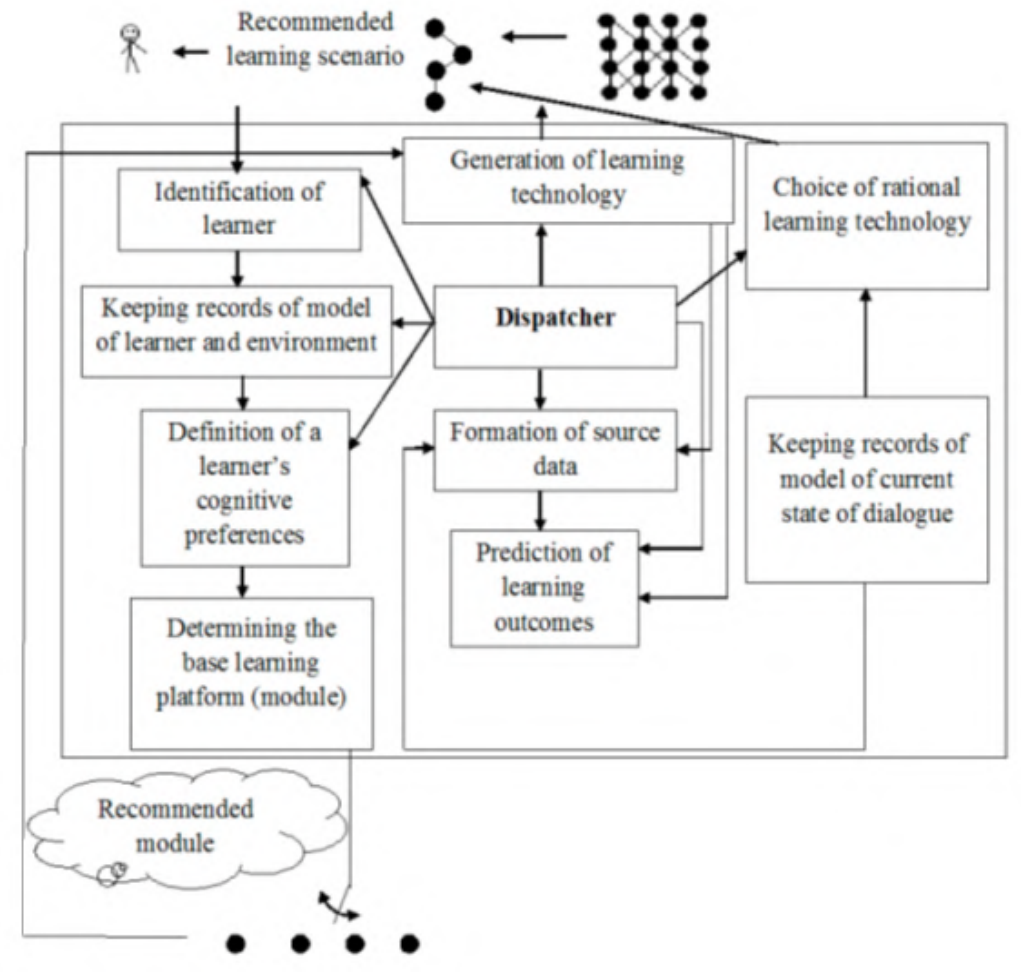
Figure 6: Presentation of paper